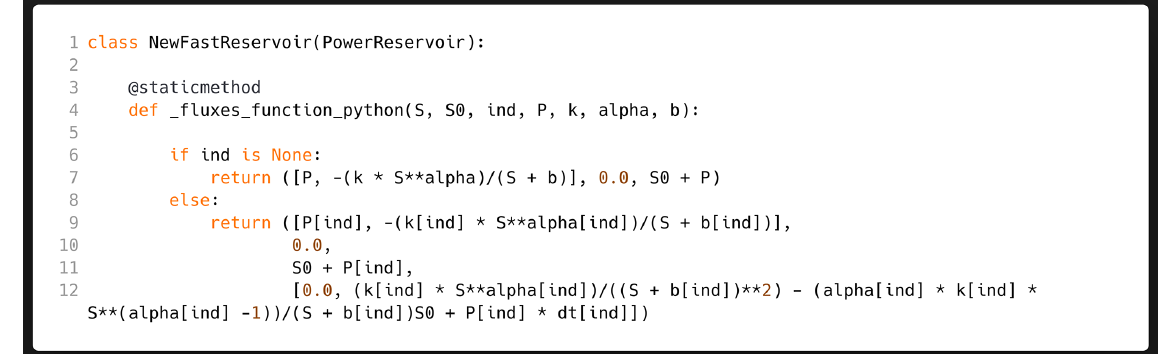
Figure 6. Simplified approach for implementing the NewFastReservoir by inheriting directly from class PowerReservoir (Sect.